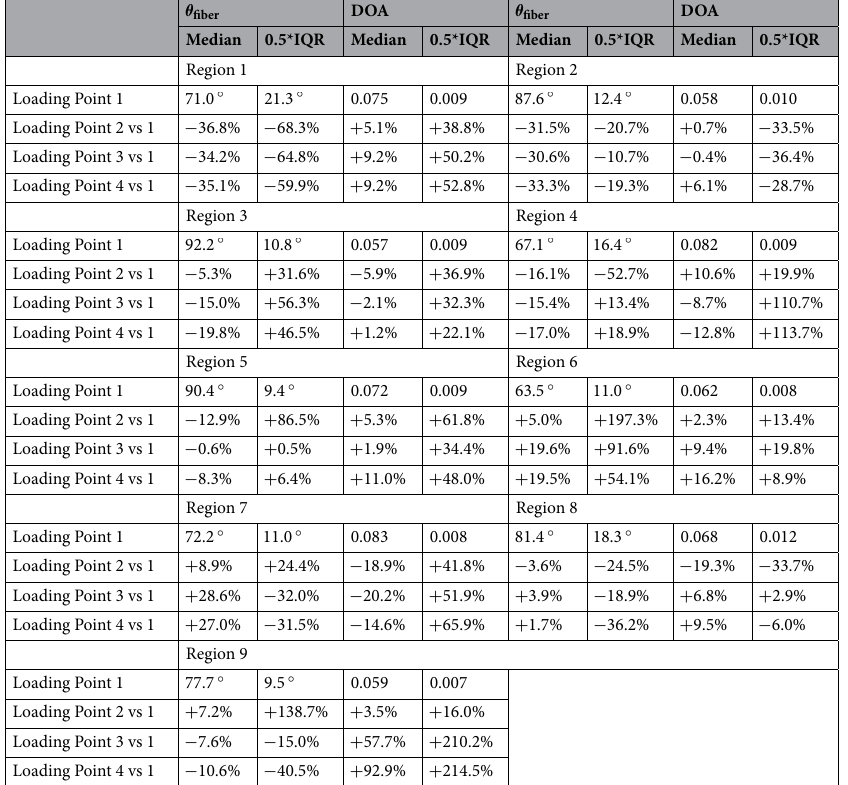
Table 2. Regional analysis of the quantified collagen fiber orientation angle θ fiber and the degree of optical anisotropy (DOA), reported as the median and interquartile range (IQR) for Loading Point 1 and the corresponding percent changes associated with Loading Points 2–4 (see Fig. S1 for the definition of the 3 × 3